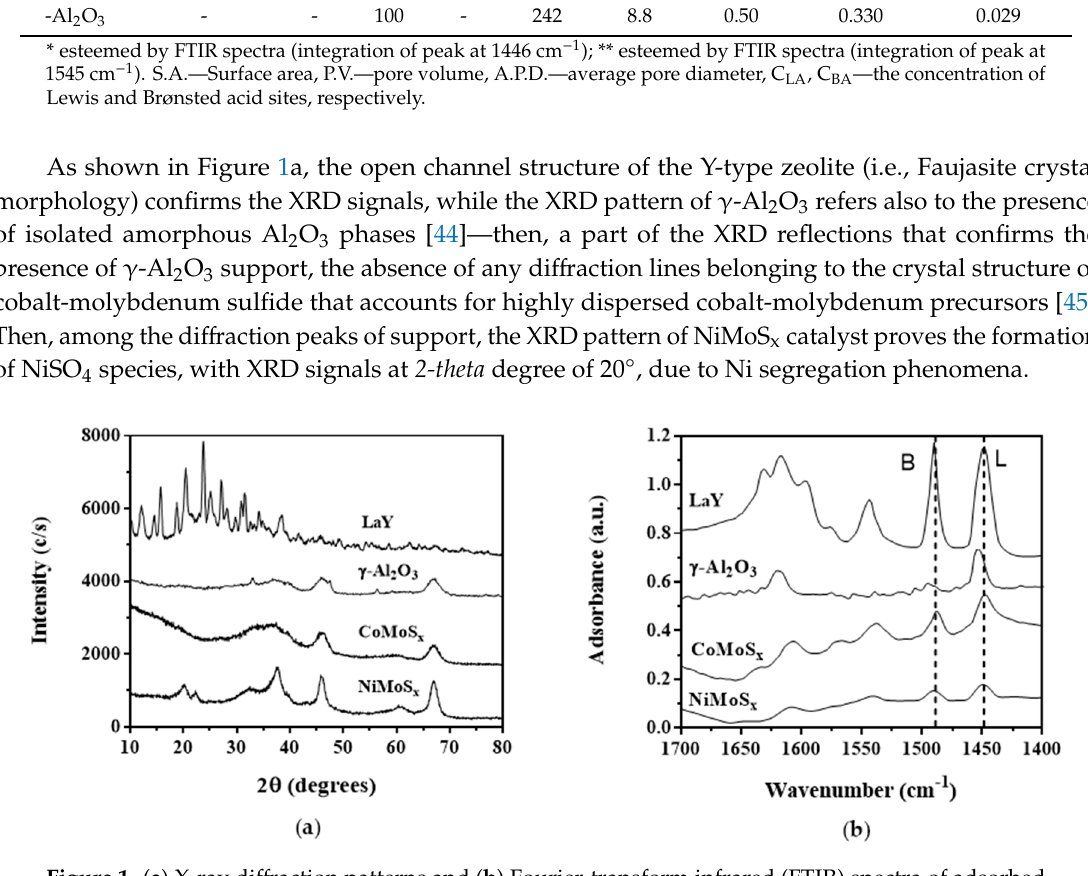
Table 1. Chemical-physical properties and acid sites quantification of catalysts.